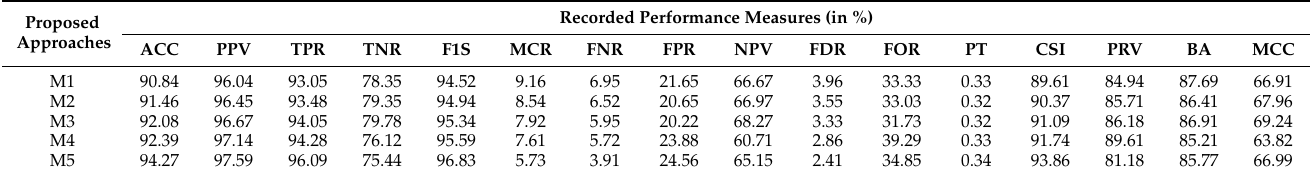
Table 7. Recorded results of performance parameters based on various proposed